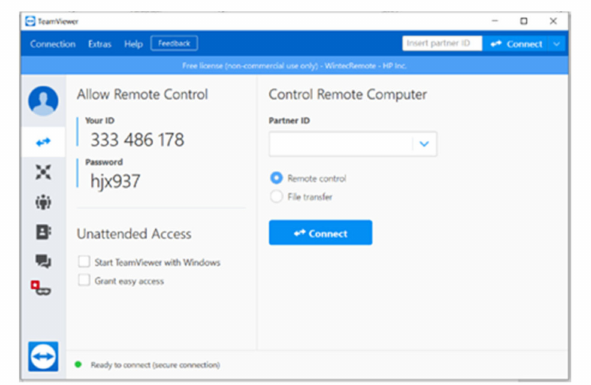
Figure 7. TeamViewer window.